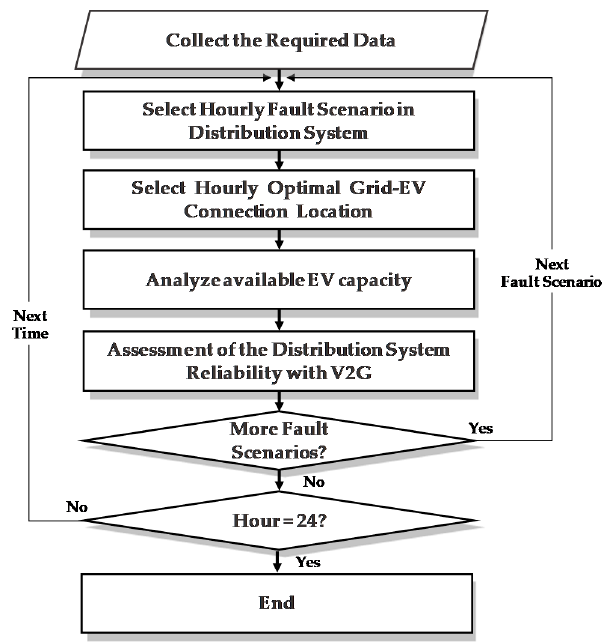
Figure 1. Flowchart of the proposed method for the system reliability assessment .